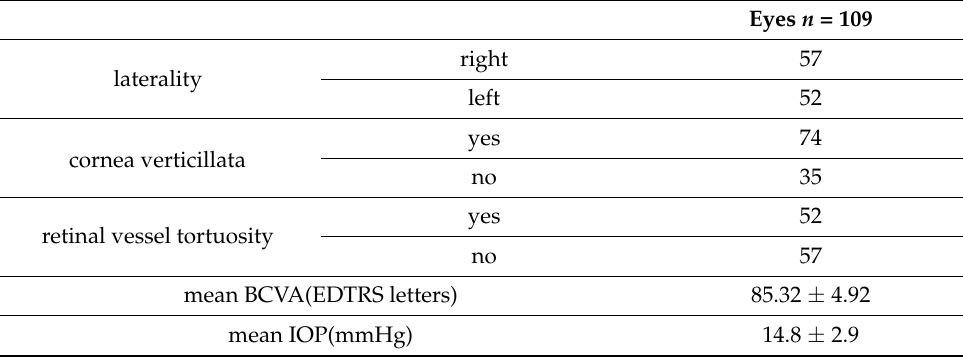
Table 3. Ocular characteristics of study